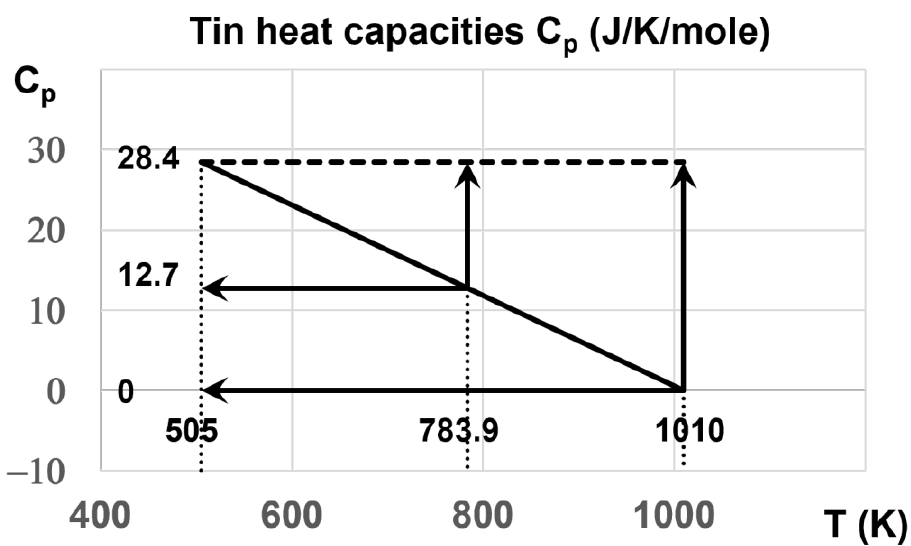
Figure 8. Heat capacities of tin in J/K/mole. C p = 28.43 from T = 505 to 1010 K in the absence of glassy phase. C p = 12.7 from T m = 505 to T g = 783.9 K in the presence of glassy fraction f = 55.23%. C p = 0 for f = 100%. Heating beyond T g , leads to C p = 28.43 inside the transition width. Cooling from a temperature slightly below T g leads to the glassy state.